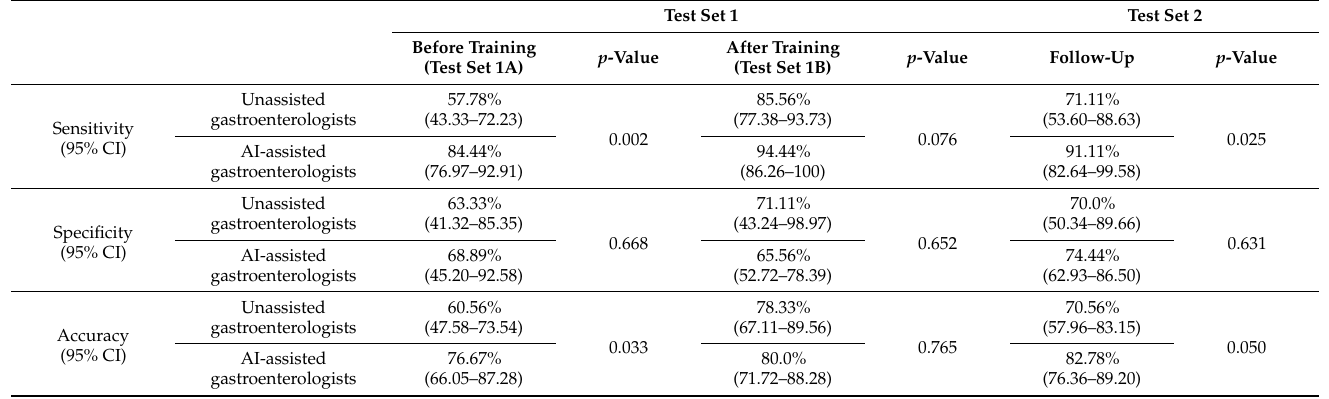
Table 2. Diagnostic test scores of unassisted and AI-assisted gastroenterologists at various testing moments.